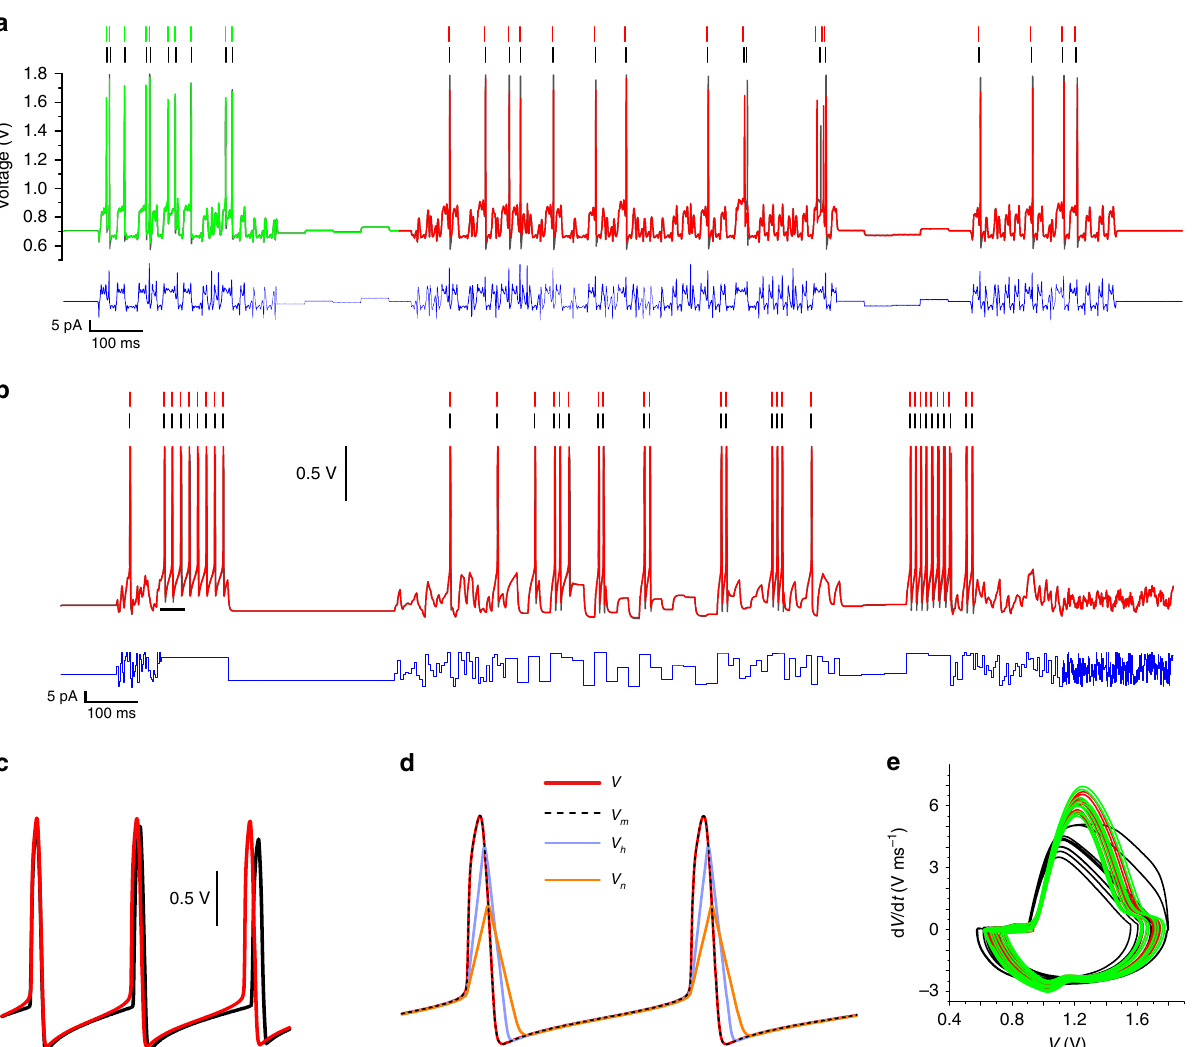
Fig. 2 Twin experiment with a solid-state neuron. a Membrane voltage of a sub-threshold neuron (black line) stimulated by a current protocol mixing hyperchaotic oscillations with current steps (blue line). The membrane voltage was measured from a VLSI chip implementing the NaKL SSN model. The SSN model was synchronized to the data over a T = 600-ms-long assimilation window (green line). The complete model con fi gured with the estimated parameters was then forward integrated from t = 600 ms onwards to t = 2000 ms to predict the membrane voltage (red line). b Membrane voltage predicted by the completed SSN model for a different current protocol consisting of fast and slow-varying steps (red line). VLSI membrane voltage measured on the VLSI neuron (black line). c Detail of membrane voltage oscillations showing the shape of predicted and actual action potentials. d Predicted time dependence of state variables V , V m , V h and V n . e Phase portrait of action potentials over the assimilation window: VLSI experiment (black line), fi tted (green line) and predicted from t = 0 (red